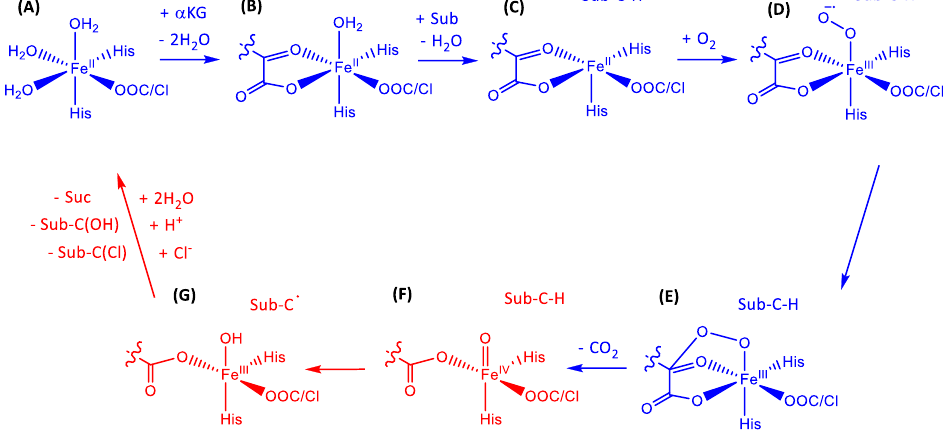
Figure 8. Catalytic mechanism of nonheme iron halogenases and hydroxylases.